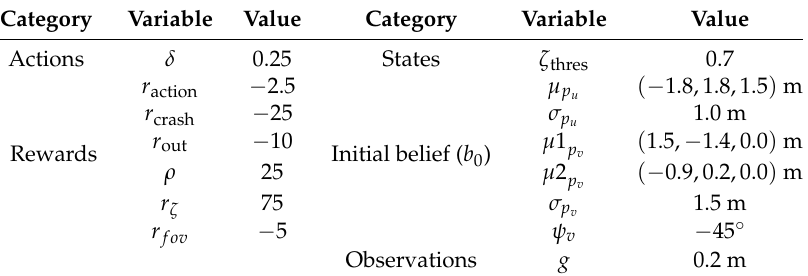
Table 2. Hyperparameter values for the Partially Observable Markov Decision Process (POMDP) formulated problem. The initial belief position and orientation values were defined in reference to the world coordinate frame.